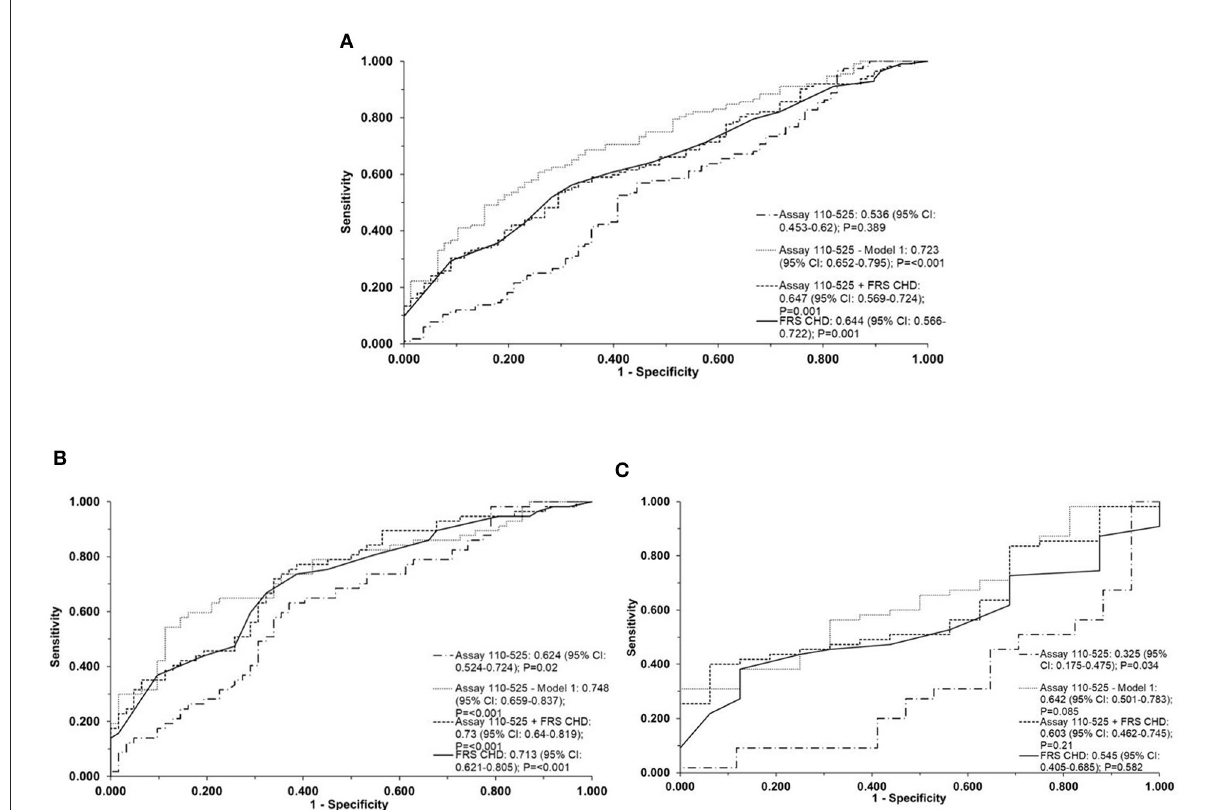
FIGURE3 Direct two-site apoA-I assay 110-525 as predictors of coronary atherosclerosis. The ROC curve of the direct two-site apoA-I assay 110-525, assay 110-525 combined with age and sex (Model 1), direct two-site apoA-I assay 110-525 combined with a 10-year coronary heart disease risk using the Framingham Risk Score (FRS CHD), and the FRS CHD alone for detection of coronary atherosclerosis in the whole population (A) , in patients without LLM (B) and in patients on LLM (C) . The area under the curve (AUC) (95% CI) and the P -values are represented in the bottom right-hand corner of the figure. The assay 110-525, Model-1, used age and gender as the covariates. The FRS CHD estimation included age, gender, smoking, hypertension, diabetes, HDL-C, and LDL-C. ROC, receiver operator characteristic; LLM, lipid-lowering medication;